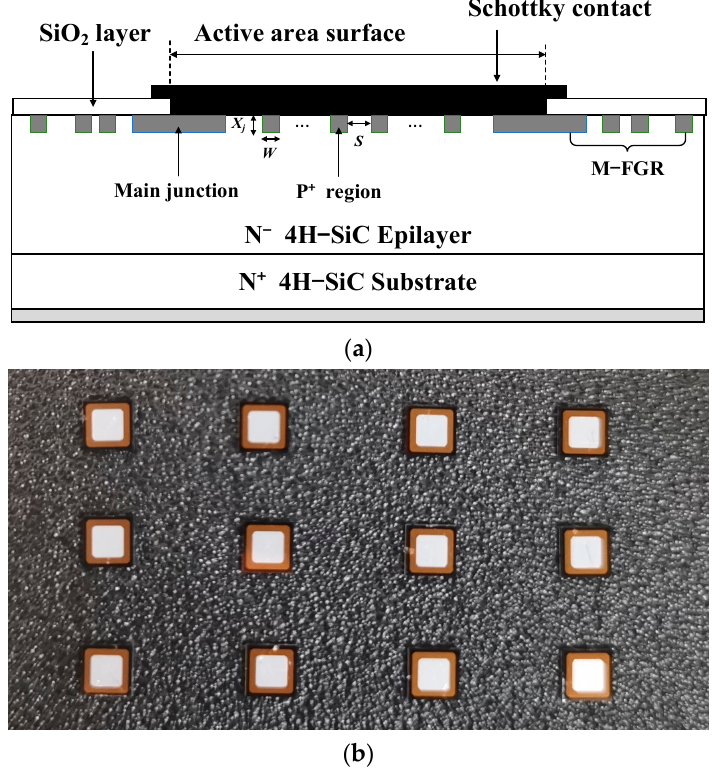
Figure 1. ( a ) Schematic cross-section of 4H-SiC device. ( b ) The photo of Schottky barrier diodes.